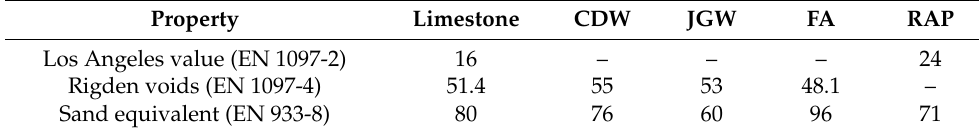
Table 1. Physical and mechanical properties of the limestone aggregates and waste materials after size